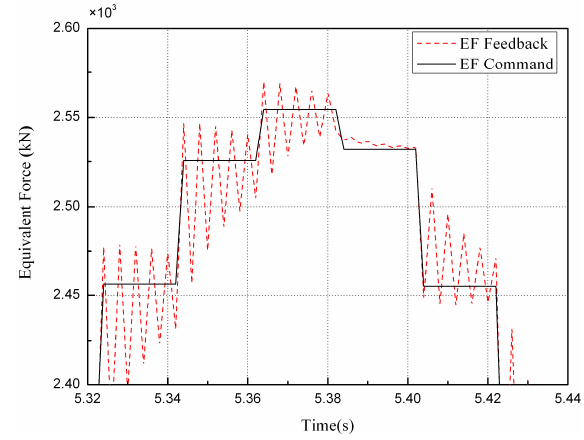
Figure 17. Comparison of the EF feedback and EF command when K P = 0.9, K I = 0.0065.